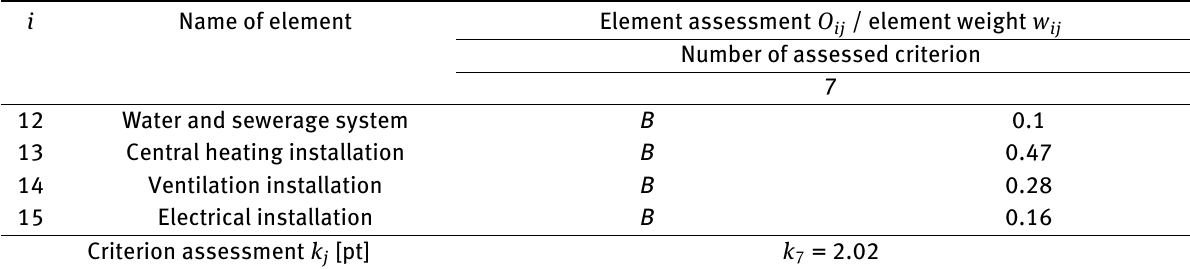
Table 4: Evaluation of the building according to the criterion k